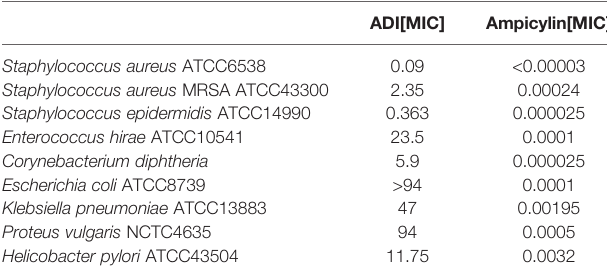
TABLE 2 | Antimicrobial activity of ADI and ampicillin [mg/mL].